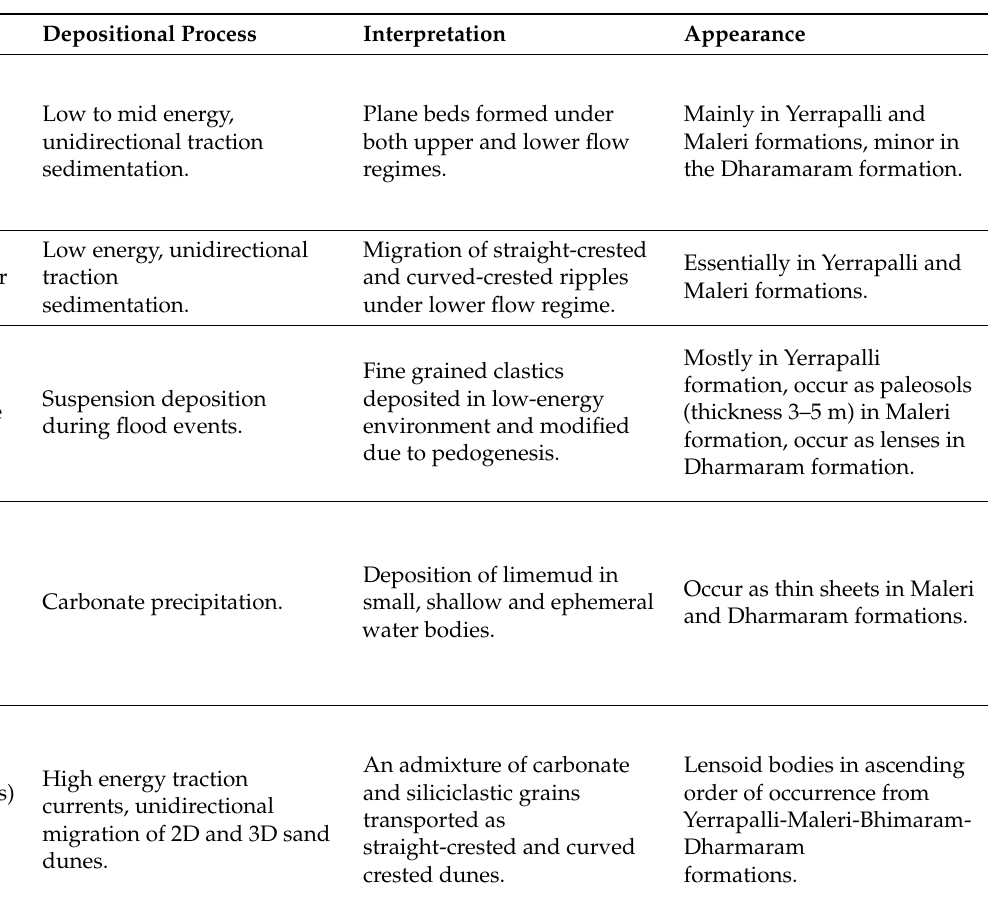
Table 2. A brief facies analysis (mainly the siliciclastics) and their main characteristics, in relation to sedimentary structures, depositional environments and appearance in the four formations (discussed in this paper) of the Upper Gondwana succession of the Pranhita-Godavari basin, central